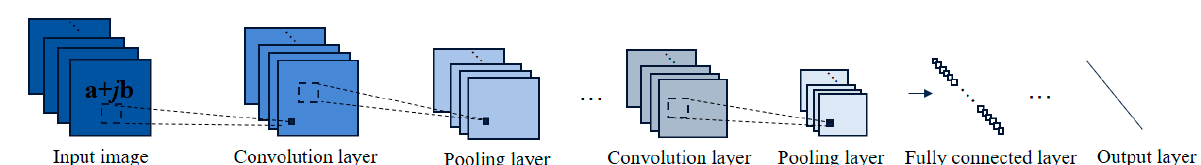
Figure 1. Framework of the CV-CNN model.